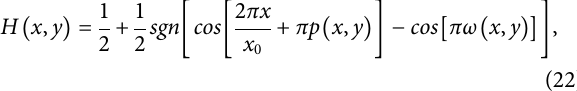
Frontiers in Physics |